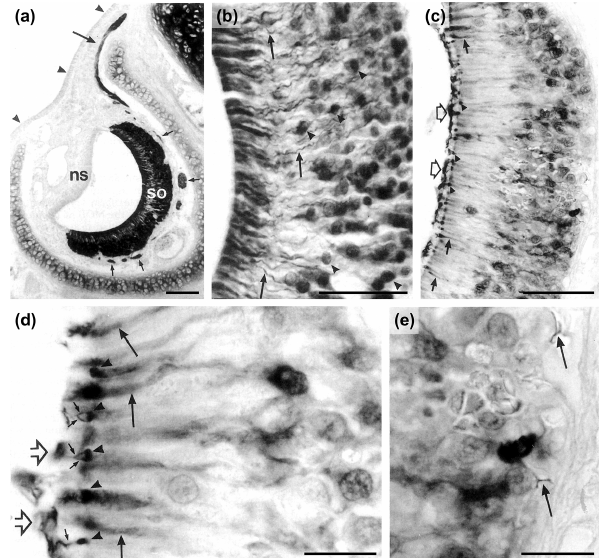
Figure 8. Calretinin immunoreactivity in the vomeronasal organ of adult Tupaia belangeri . (a) Immunoreactivity in the sensory epithe- lium (so), in vomeronasal nerve fiber bundles (small arrows), and in the vomeronasal nerve (large arrow). Arrowheads, respiratory epithelium; ns, non-sensory epithelium. (b) Immunopositive so- mata (arrowheads) and dendrites (arrows) of receptor cells. (c) Im- munoreactivity in the mucus (open arrows), dendrites (solid ar- rows), and dendritic clubs (arrowheads) of receptor cells. (d, e) En- larged from (c) . (d) Immunoreactivity in the mucus (open arrows), clumps of microvilli (small solid arrows), dendritic clubs (arrow- heads), and dendrites (large solid arrows). (e) Immunopositive re- ceptor cells and their axons (arrows). Scale bars = 150µm in (a) ; 50µm in (b, c) ; 15µm in (d, e) . Reproduced from Malz et al. (2000, Fig. 5). © 2000 Wiley-Liss, Inc., by permission of John Wiley & Sons,